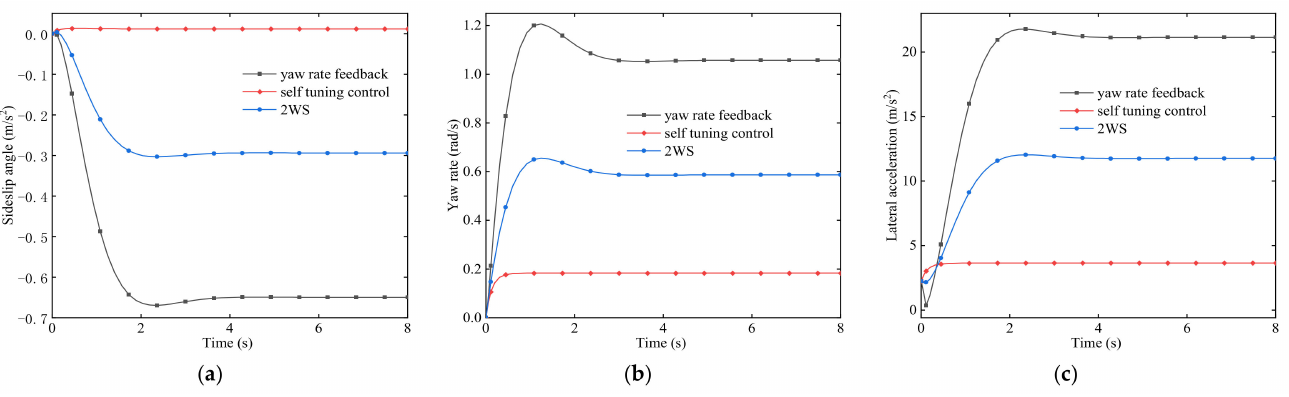
Figure 7. Comparison of different controllers. ( a ) Sideslip angle. ( b ) Yaw rate. ( c ) Lateral